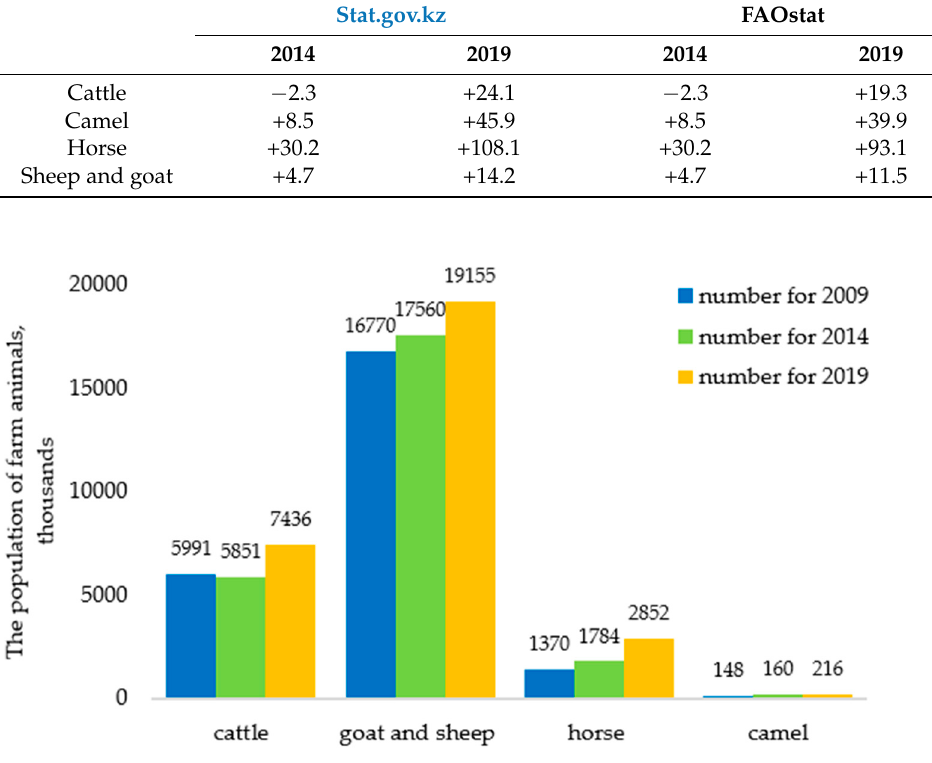
Figure 10. Number of livestock in the Republic of Kazakhstan for 2009, 2014, 2019. Source: Stat.gov.kz, 2021. Available online: https://stat.gov.kz/ (accessed on 26 May